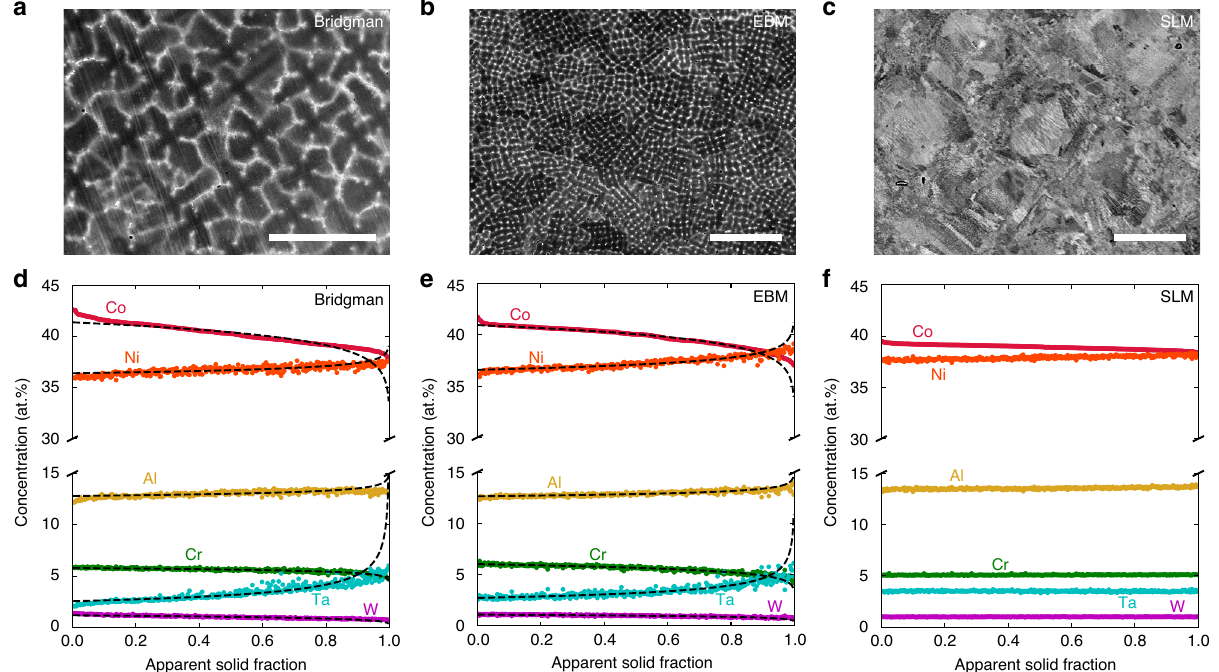
Fig. 2 As-printed chemical segregation after Bridgman casting, EBM, and SLM. BSE micrographs of the XY -plane microstructures of SB-CoNi-10 after fabrication through a Bridgman casting, b EBM, and c SLM. Quantitative compositional data and Scheil curve fi ts for the apparent distribution coef fi cients are shown for the d Bridgman, e EBM, and f SLM samples. EPMA grid scans of 20 × 20 evenly spaced points were collected in the centers of the BSE images shown in a – c with grid dimensions of a 1 × 1 mm and b , c 100 × 100 μ m. Scale bars for a , b , and c are 500, 50, and 50 μ m, surface on the measured values. By sorting this compositional data from highest Co content to lowest Co content, the compo- sition of the solid at each apparent solid fraction, or f s , for each of the major alloying additions can be estimated and is shown in Fig. 2d – f. By fi tting these curves with the Scheil equation 55 , which describes solute segregation during solidi fi cation under the assumption of no diffusion in the solid and in fi nite diffusion in